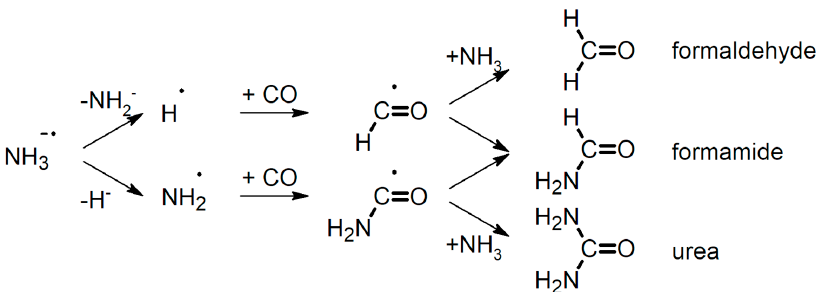
Figure 3. Possible reaction pathways from ammonia to formamide as well as the two expected side-products formaldehyde and urea.